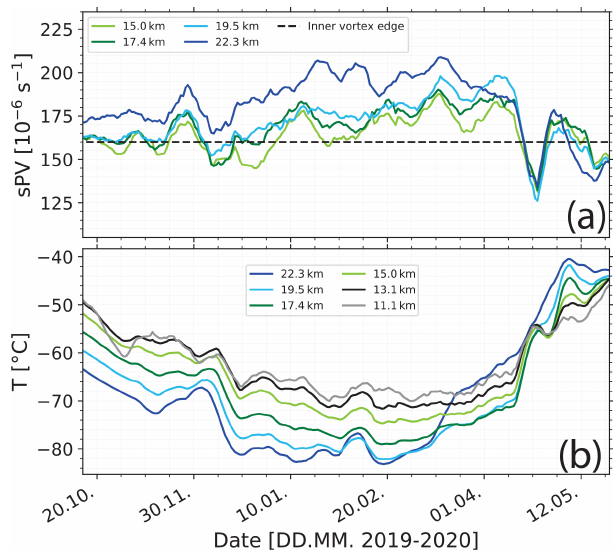
Figure 8. (a) Scaled potential vorticity (sPV) and (b) temper- ature T along the Polarstern drift route (Fig. 7) for up to six height levels indicated by different colours. sPV values exceeding 160 × 10 − 6 s − 1 (vortex edge; thick horizontal line in a ) for heights > 17km indicate that Polarstern was below the strong vortex from mid-December 2019 to mid-April 2020. The polar vortex began to collapse around 20 April (deep sPV minimum in a ). A downward trend in temperature is visible in panel (b) until the end of Febru- ary 2020. Favourable conditions for PSC formation were given at heights > 17km from 20 December 2019 to 10 March 2020.